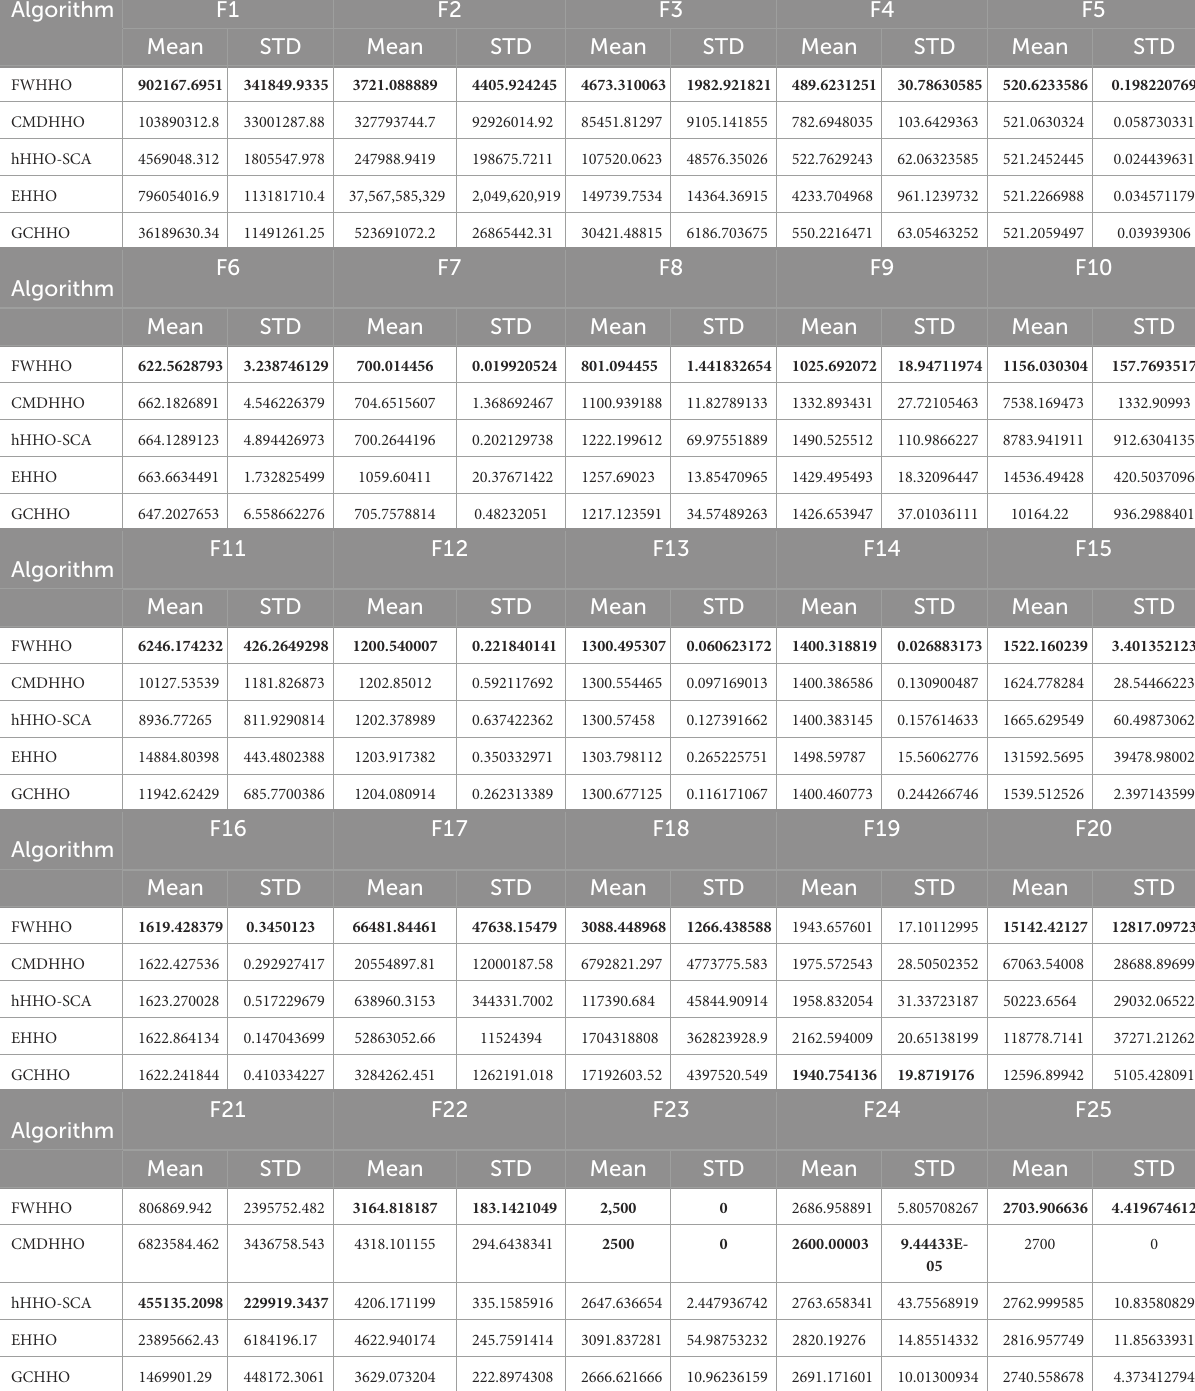
TABLE 3 Comparison of FWHHO and existing HHO